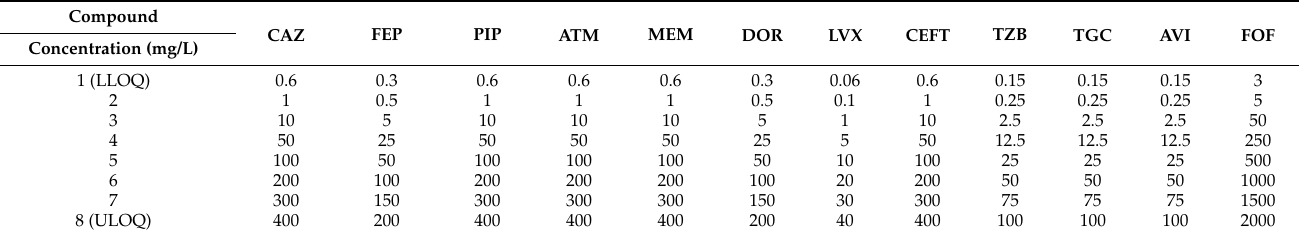
Table 1. Nominal concentrations used in calibrators and QCs for all antibiotic compounds in plasma and